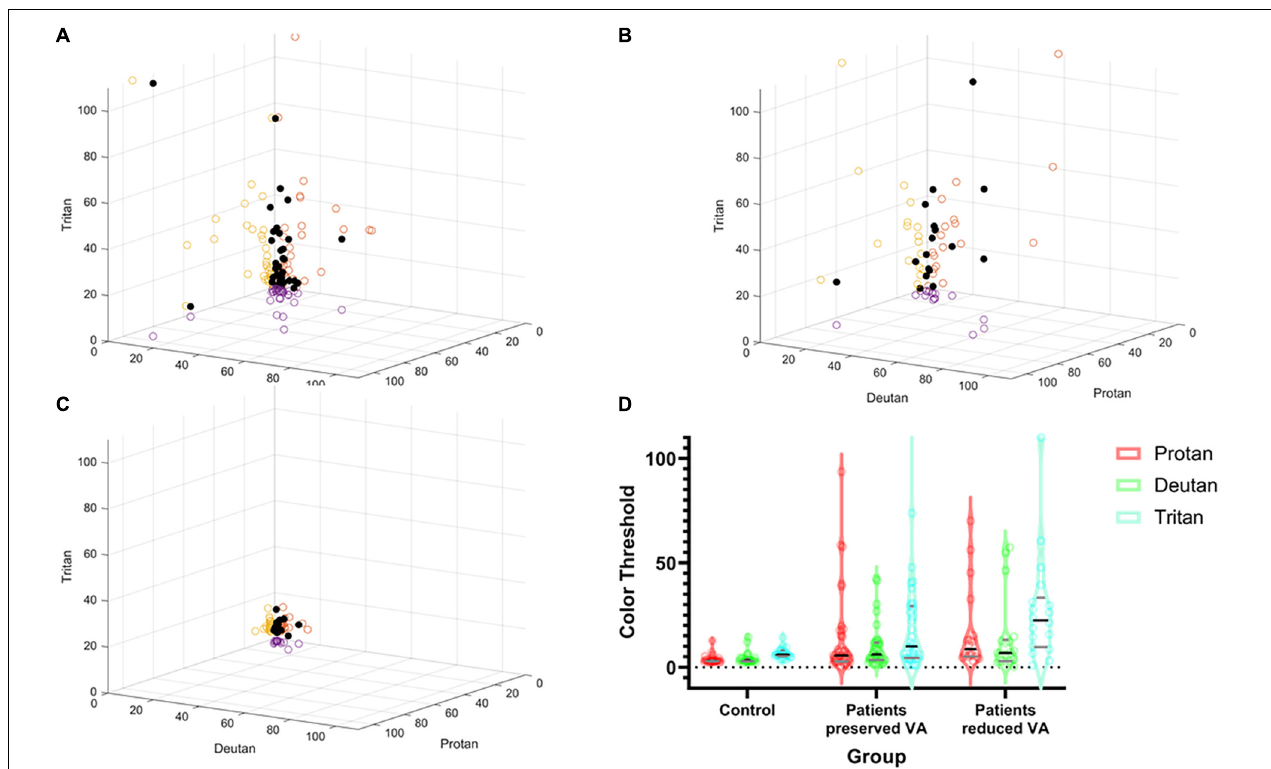
FIGURE 3 | Summary of color discrimination results. Spread of individual data points plotted against protan, deutan, and tritan scores on the X, Y, and Z axes, respectively (black dots). The circles on the axes walls show the corresponding shadows of the results on each axes separately. (A) Choroideremia eyes with preserved BCVA. (B) Choroideremia eyes with reduced BCVA. (C) Control eyes. The higher the number, the greater the degree of the color defect against the corresponding axis. (D) Pirate plot of group differences. The outer envelope shows the spread of the raw data with the widest point showing the mean and the black line representing the median. The gray lines represent the interquartile range. Additionally, dots represent each raw data measurement point.